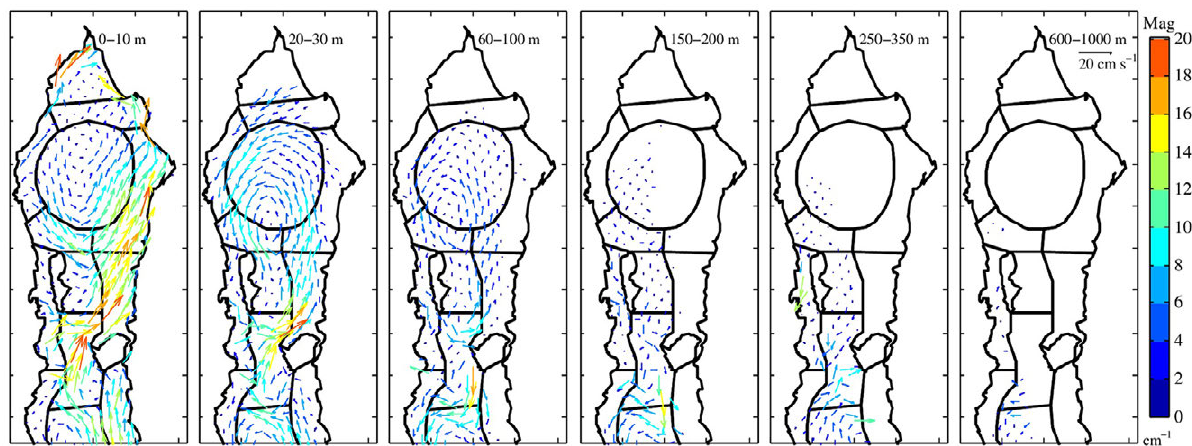
Fig. 2. – Average currents for the months of July and August for the indicated model layers.